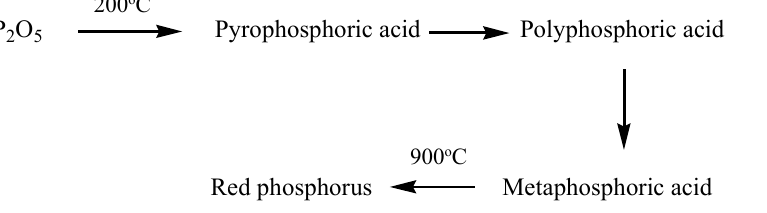
6 of 26 Figure 3. Synthesis of P-GNS using phosphorous trichloride (PCl 3 ) and benzene (C 6 H 6 ) as precur- sors. Adapted from Billeter et al. [74], with permission from the American Chemical Society.